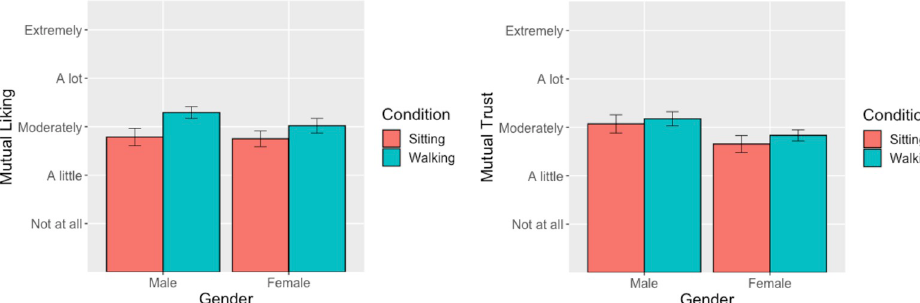
Fig 5. a. Mutual Liking x Condition x Gender. Note : Error bars reflect standard errors of the mean. b. Mutual Trust x Condition x Gender. Note : Error bars reflect standard errors of the mean.